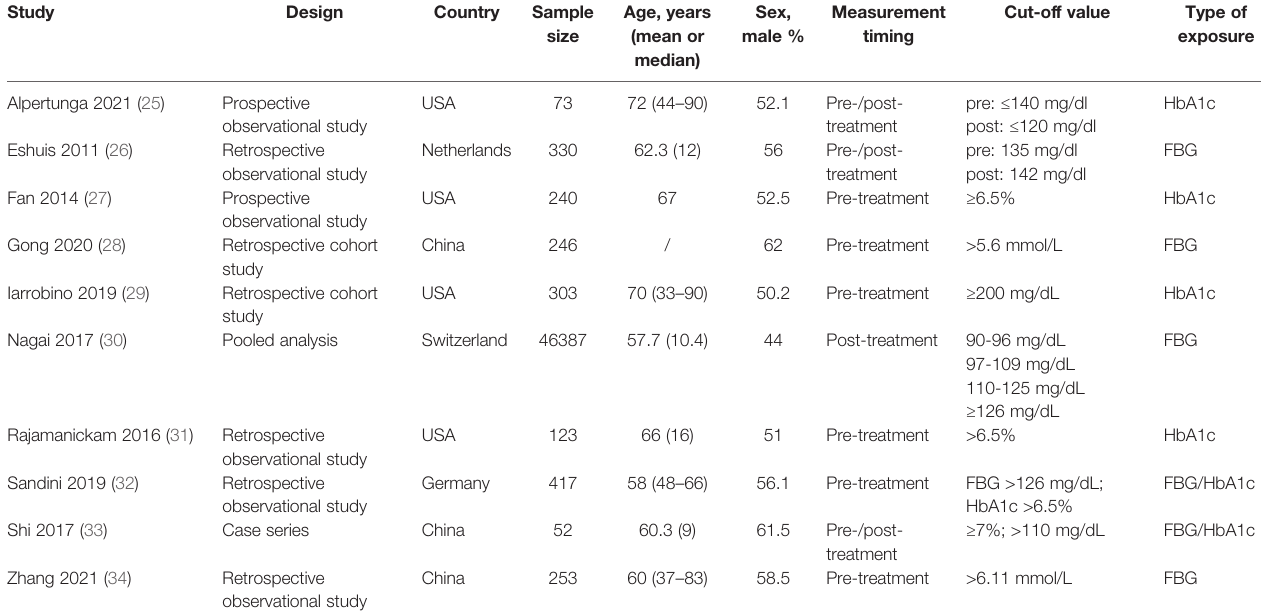
TABLE 1 | Characteristics of the included studies.